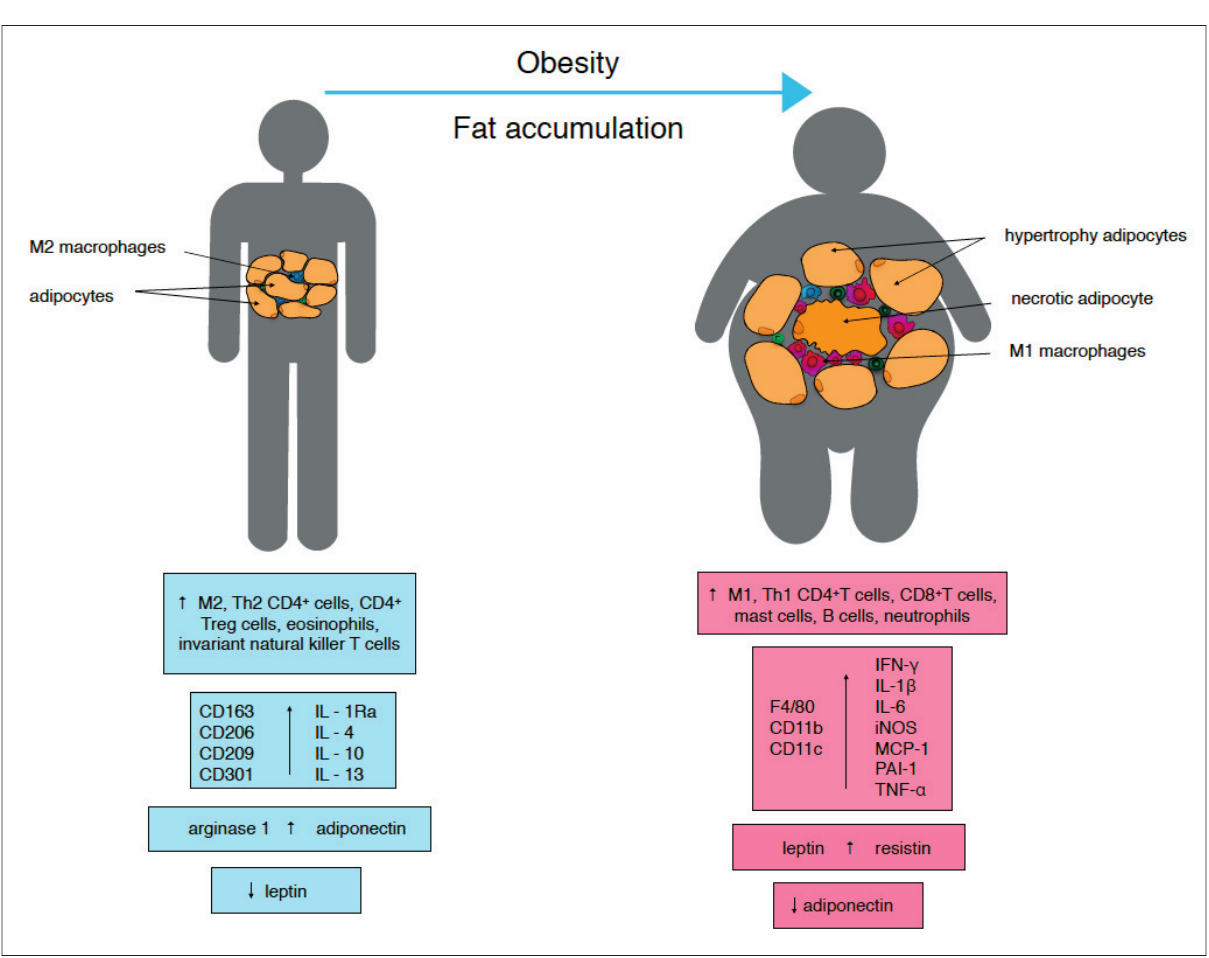
Fig. 1. The comparison of substances released by lean vs. obese